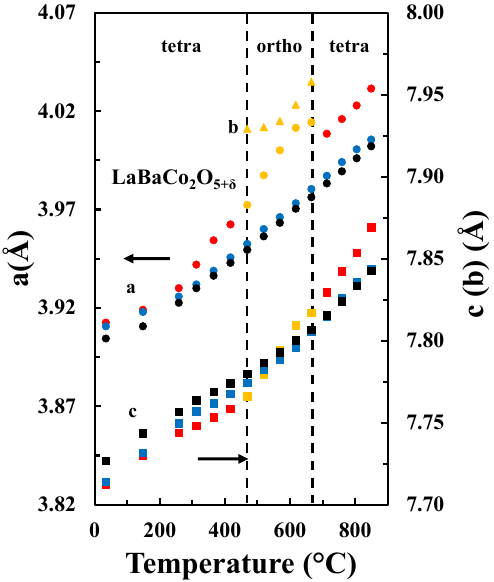
Figure 6. a (circles) and c (squares) tetragonal cell parameters and a (orange circles), b (orange triangles) and c (orange squares) orthorhombic cell parameters as a function of temperature in O 2 (black), air (blue) and N 2 (red and orange) for LaBaCo 2 O 5+ δ .